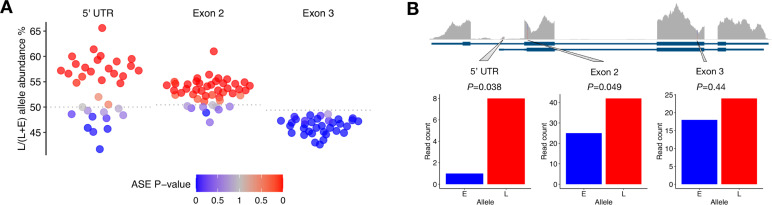
Allele-specific expression of transcribed SNPs supports a cis-regulatory basis for differences in vgll3 isoform expression.(A) RT-ddPCR assays of vgll3 allele-specific expression in heterozygotes show that alternative homozygote expression differences are conserved within heterozygotes. For the alternative 5’ UTR, exon 2 and exon 3, on average 54%, 53% and 46% of vgll3 mRNA molecules are derived from the late allele, respectively. For exon 2 and exon 3 assay the null hypothesis for testing of 1:1 allele-specific expression ratio is calculated from heterozygote DNA (dashed line, N = 10). The color scale indicates significant (blue; vgll3*E allele more expressed, red; vgll3*L allele more expressed) and non-significant (grey) allele-specific expression P-values (estimated from Poisson modelling of positive RT-ddPCR droplets). (B) Re-analysis of an independent RNA-seq data set is consistent with the RT-ddPCR results and shows allele-specific expression of an alternative 5’ UTR and exon 2. Tracks represent (from top) RNA-seq coverage, identified transcript models, and RNA-seq read coverage of SNPs. P-value are computed using a binomial test.